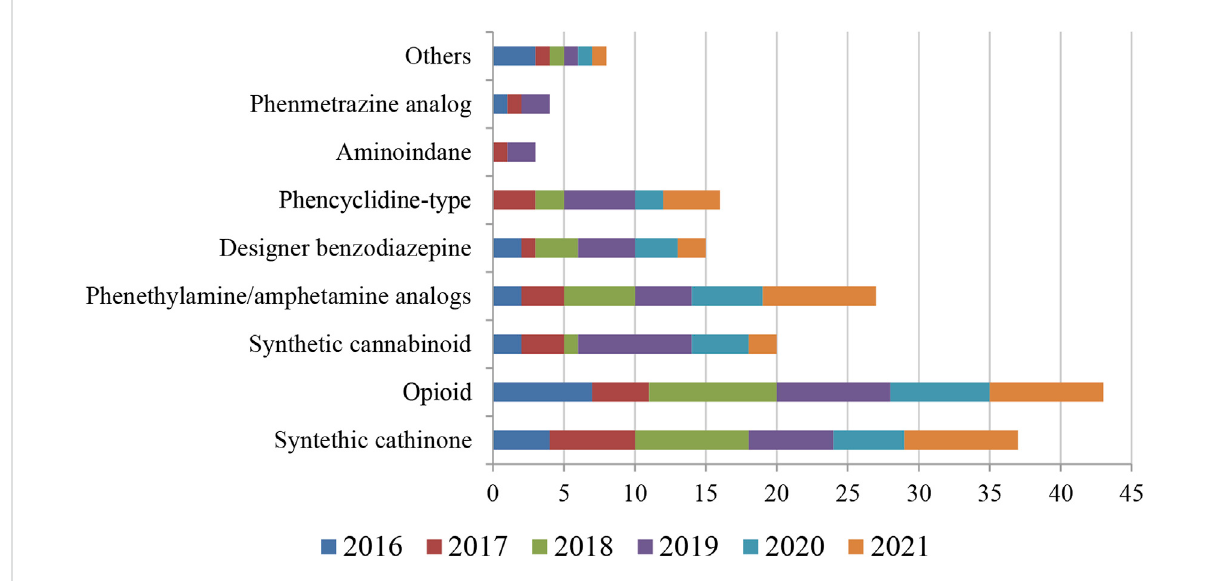
FIGURE 3 Main NPS classes reported in the publications from 2016 to 2021. Others: piperazine (2016), tryptamine (2017 – 2021), indole alkaloids found in kratom (2018 and 2019); methaqualone analog (2020). Amphetamine analogs were included in phenethylamine data. Opioid includes fentanyl and